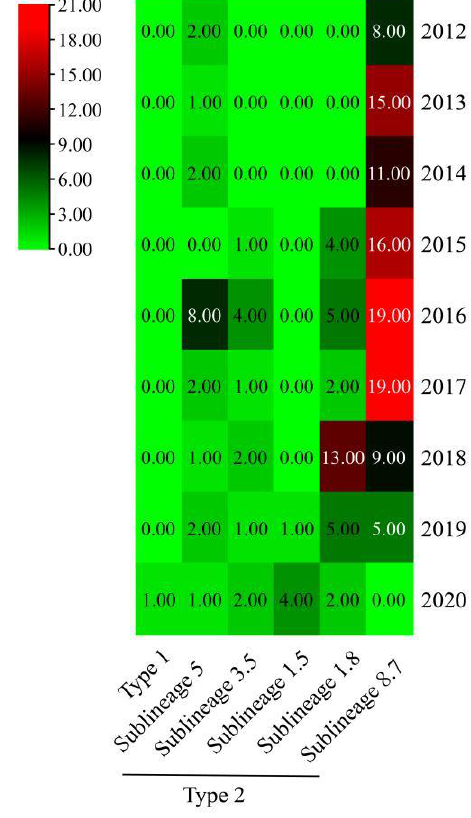
Figure 2. Heat map of the number of PRRSV strains in Sichuan from 2012 to 2020. Table 2. Nucleotide and deduced amino acid identity analysis based on ORF5 and